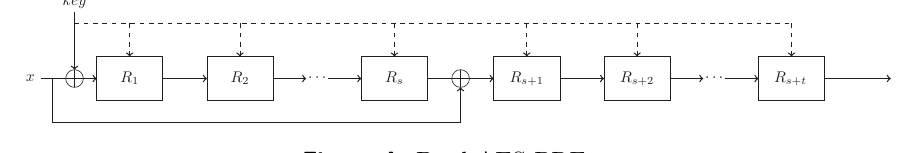
Figure 4: Dual-AES-PRF